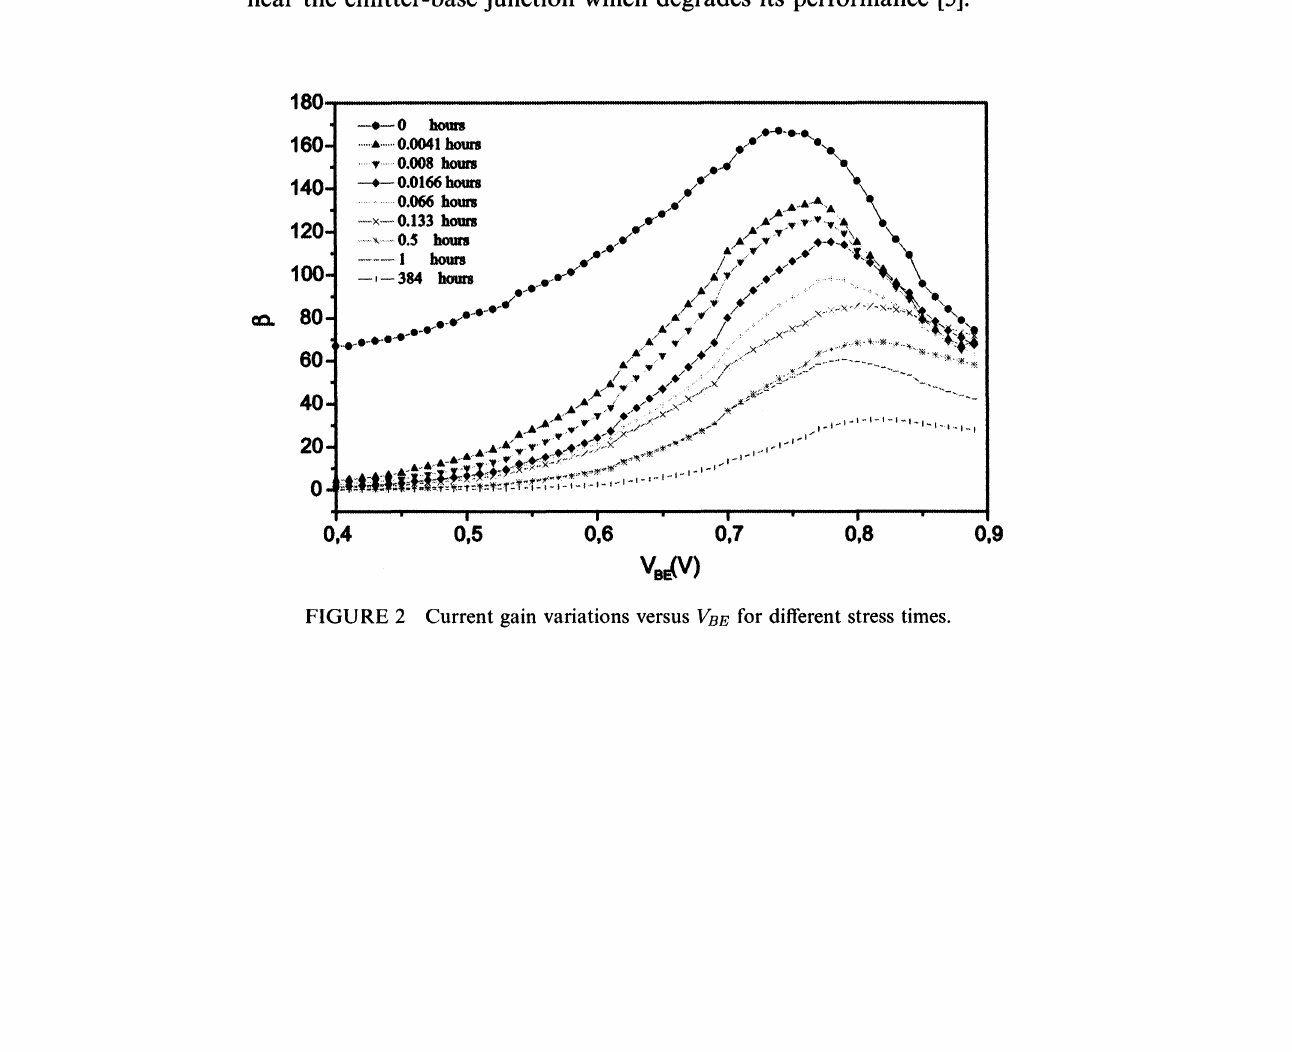
FIGURE 2 Current gain variations versus VBE for different stress